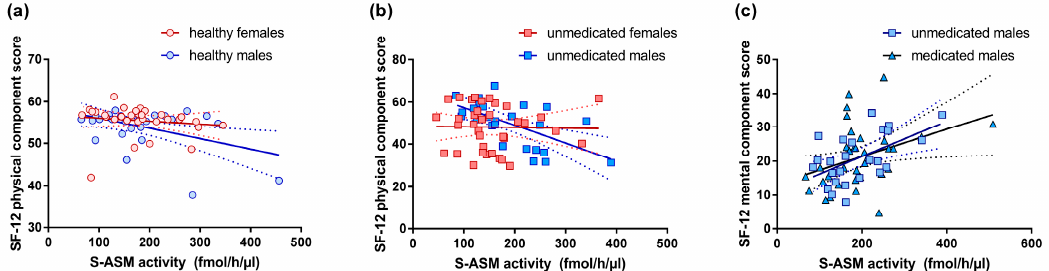
Figure 4. Correlation of serum acid sphingomyelinase (S-ASM) activity at inclusion with health-related quality of life assessed by the SF-12. High S-ASM levels were associated with a low physical component score in healthy individuals ( a ) and unmedicated patients with a current major depressive episode ( b ). High S-ASM levels were associated with a high mental component score in unmedicated and medicated male patients with a major depressive episode ( c ). Individual data with linear regression line and 95% confidence intervals.